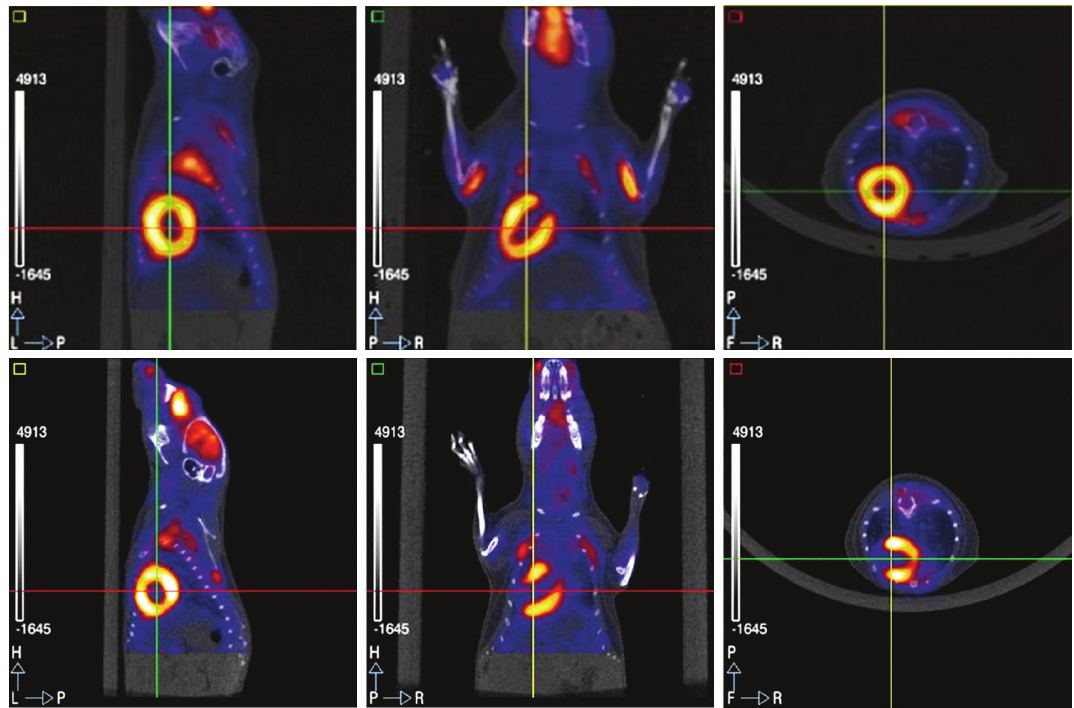
Figure 3: [ 18 F] FDG cardiac PET/CT in a normal mouse (top) and in a mouse with myocardial infarction (lower). FDG cardiac uptake is uniform in the normal mouse, while there is an area of absent uptake in the anteroapical region of the mouse with myocardial